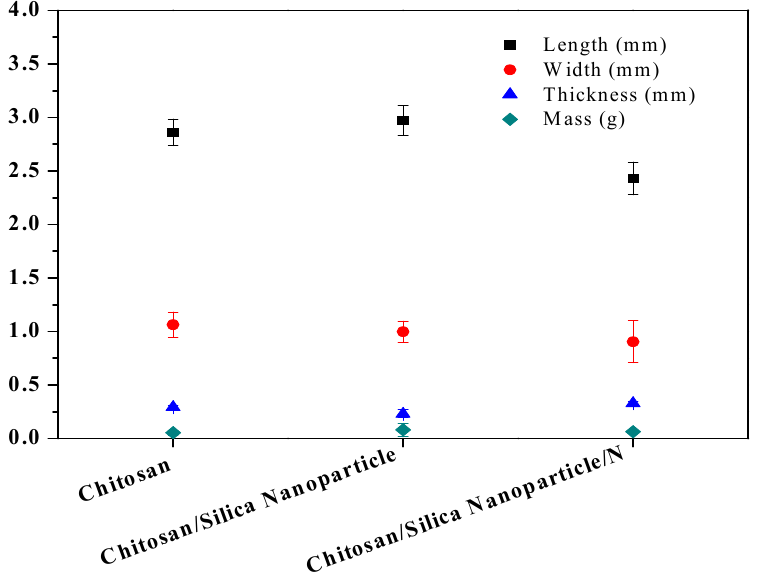
Figure 7. Some morphological properties of novel films.